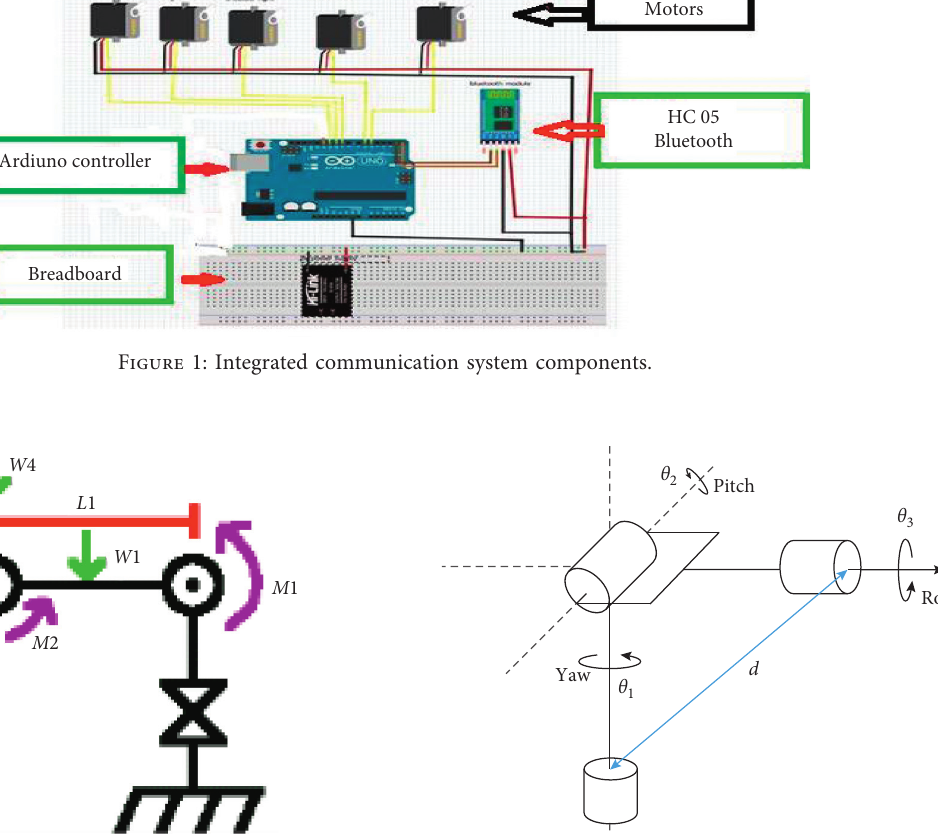
Figure 2: Schematic of the 3-DOF robot arm [20]. Table 2: Denavit–Hartenberg parameters of the robot.